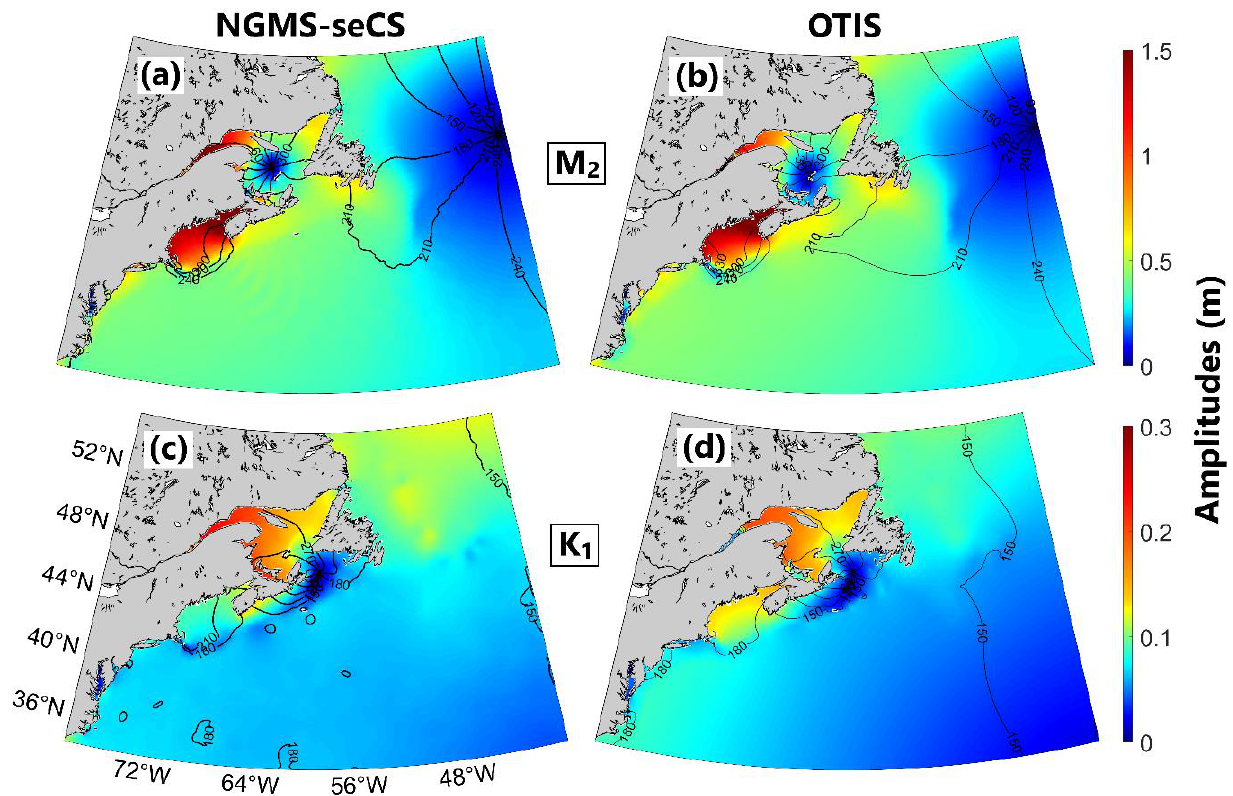
Figure 3. Co-phases (black contour lines) and co-amplitudes (color image) of the M 2 ( a , b ) and K 1 ( c , d ) tidal sea levels simulated by submodel L1 ( a , c ), and from the OTIS regional tidal model solution ( b , d